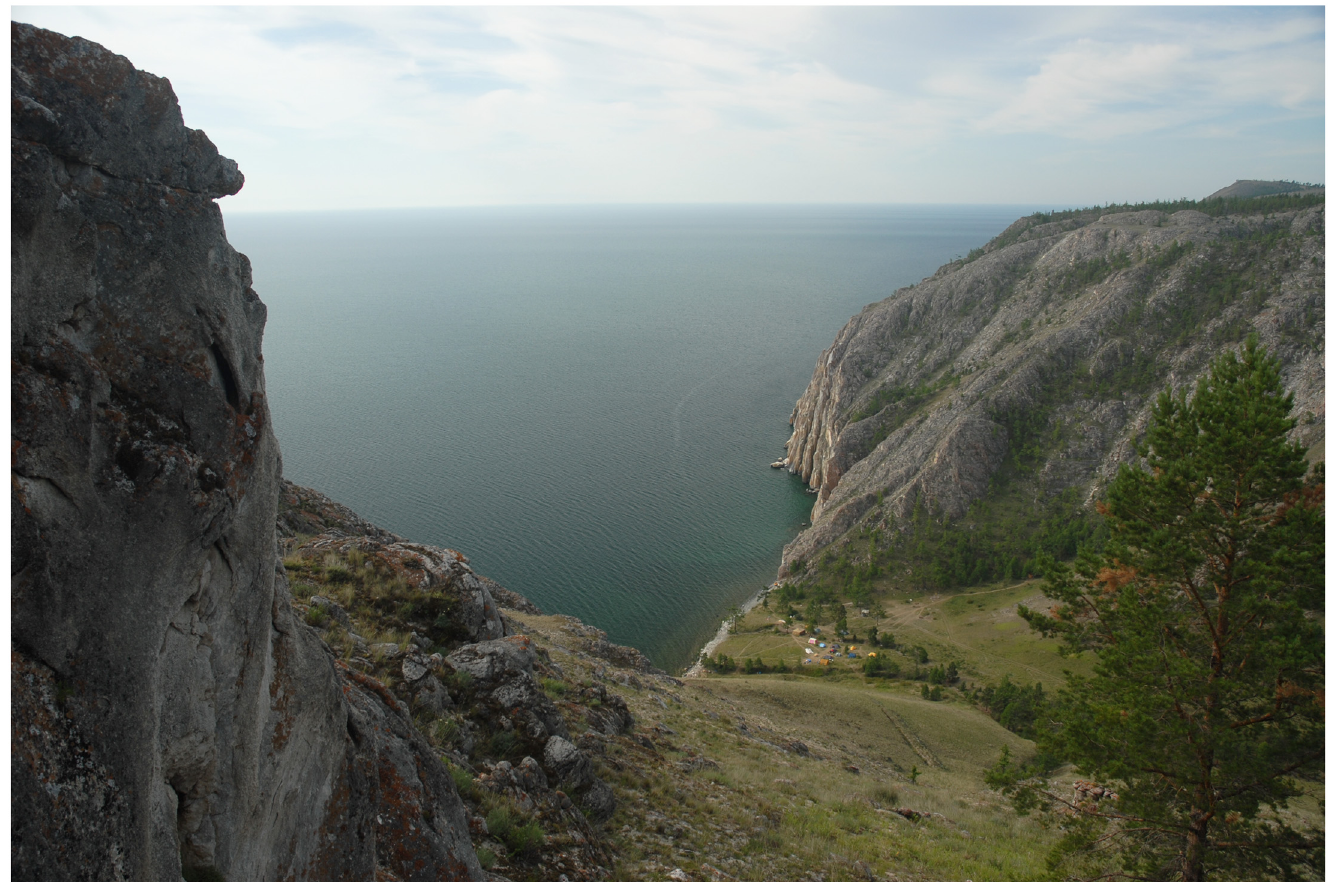
Fig 3. Photograph of Sagan-Zaba from the hill to the north of the cove, with the field camp tents visible on the valley floor. Photograph by A.